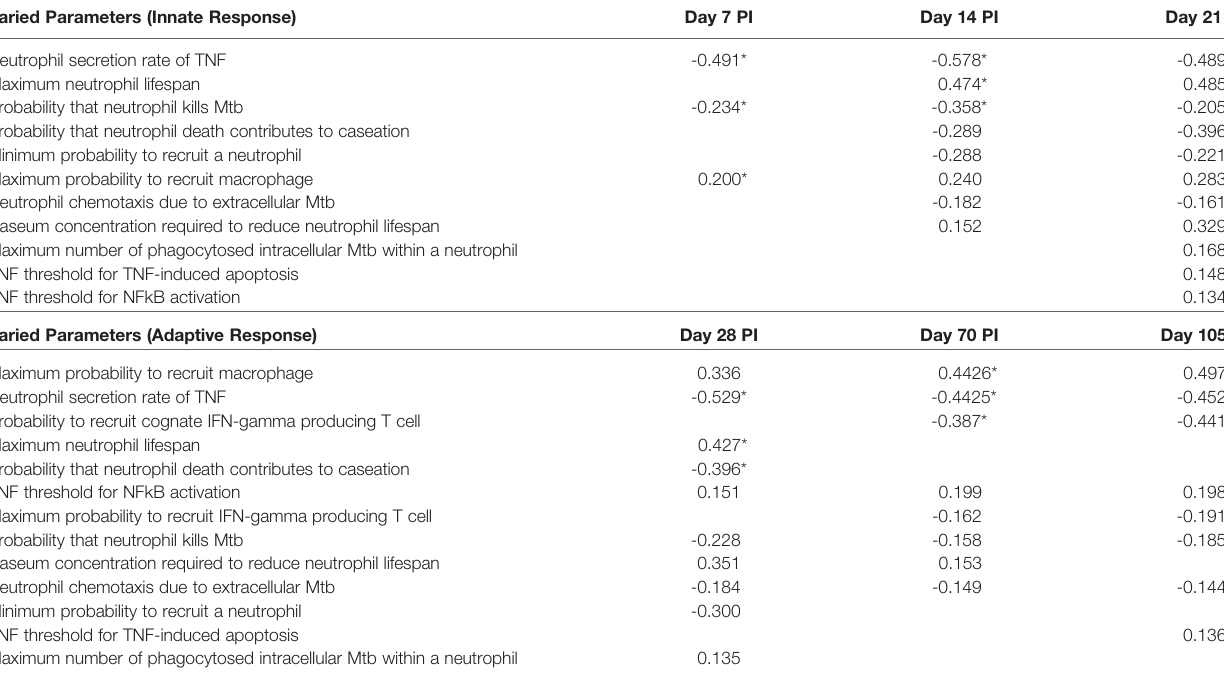
TABLE 4 | Innate versus adaptive factors driving